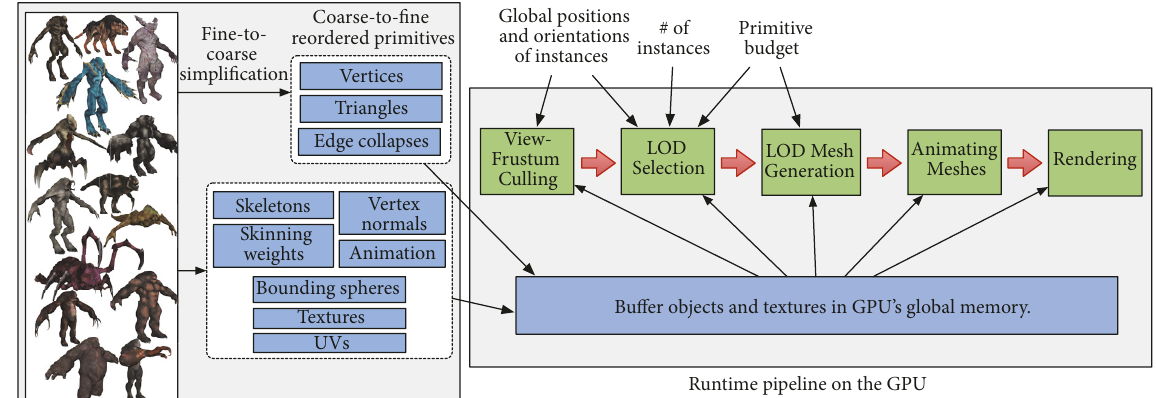
Figure 1: The overview of our